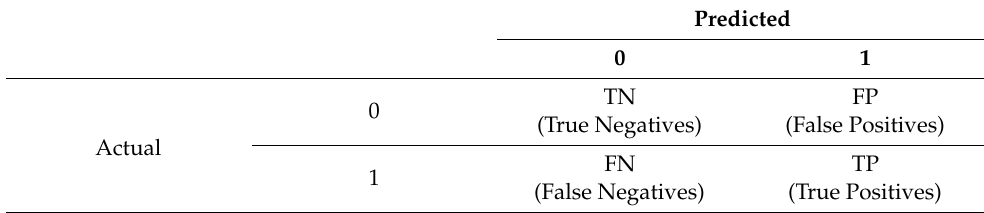
Table 2. Classification Results using a confusion matrix. True positives (TP)—number of samples correctly classified as readmissions. True negatives (TN)—number of samples correctly classified as non-readmissions. False positives (FP)—number of samples incorrectly classified as readmissions. False negatives (FN)— number of samples incorrectly classified as